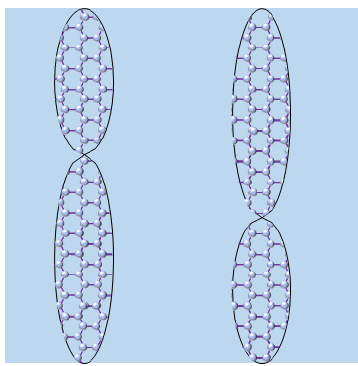
Figure 7. Broad-band terahertz metamaterial absorber based on asymmetric oval-shaped graphene patterns